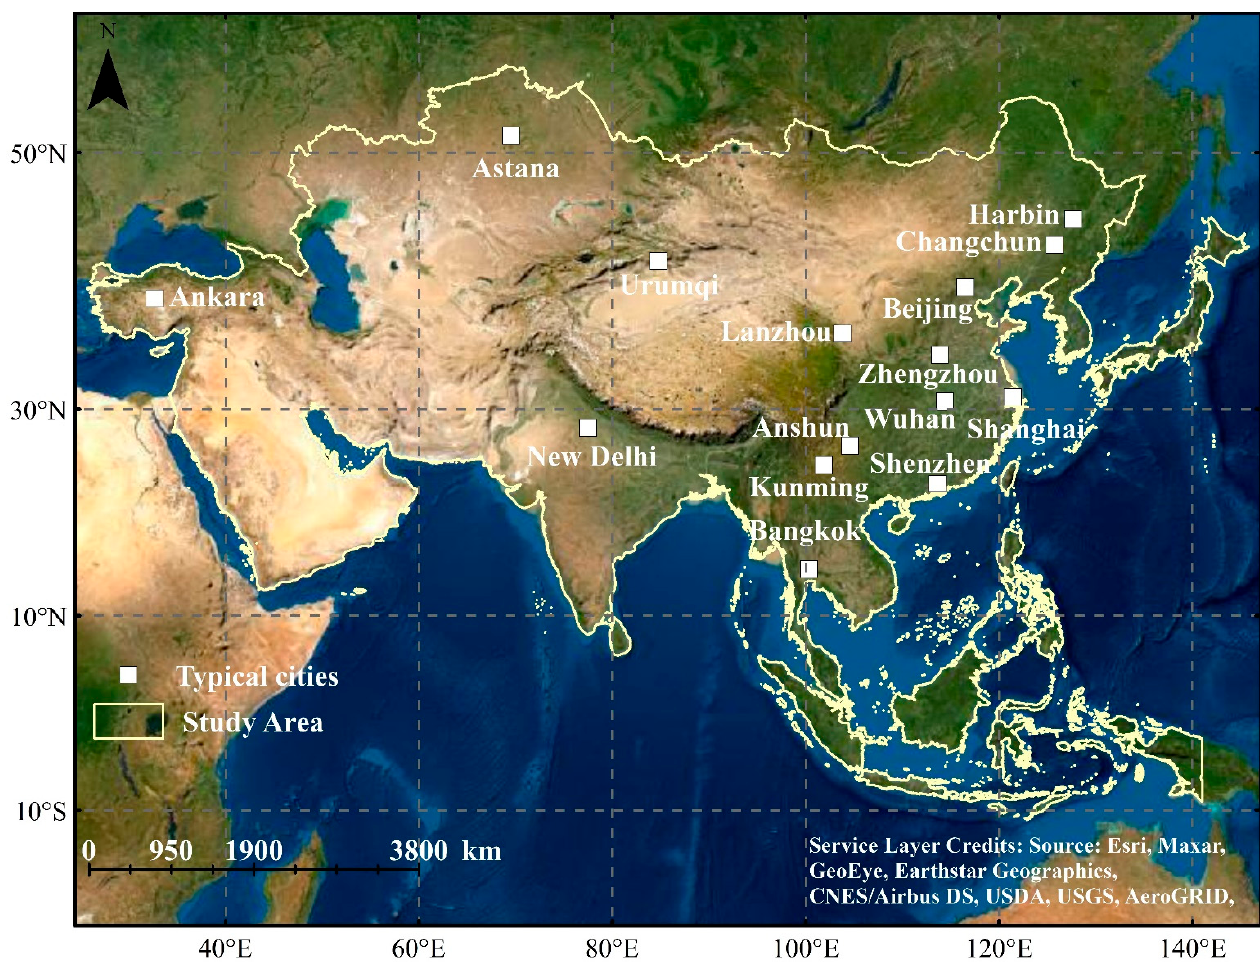
Figure 1. Location map of the study area in Asia with typical cities highlighted.